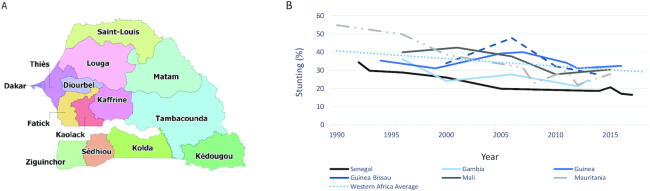
Map of Senegal (A). The prevalence of stunting in children <5 y old in Senegal and its neighboring countries in the West African Region, 1990–2018 (B). Source: (1).